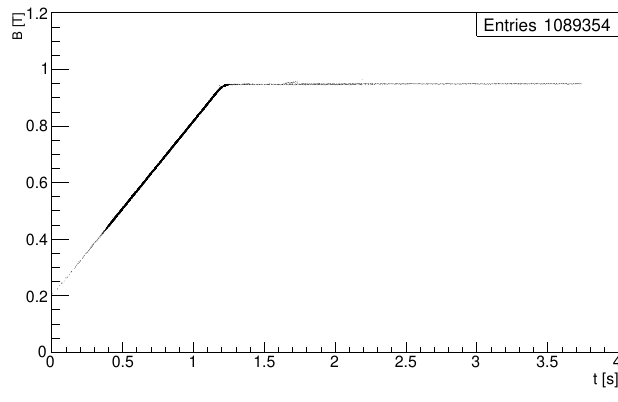
Figure 1. Dependence of the magnetic field induction on time of deuteron beam